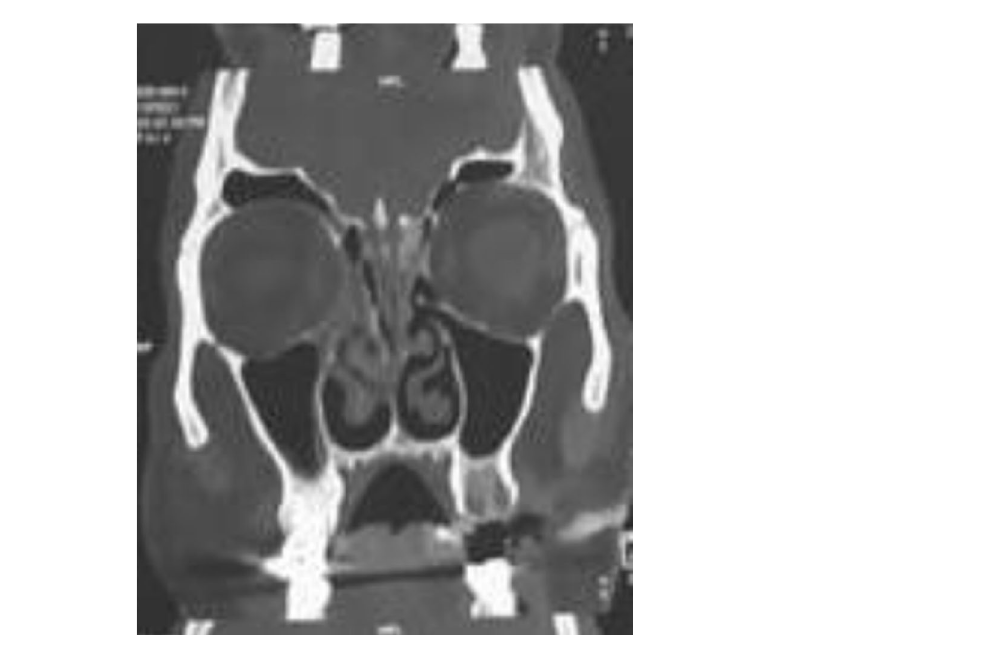
Figure 4. A male patient presented with bilateral rhino-fascial -cerebral